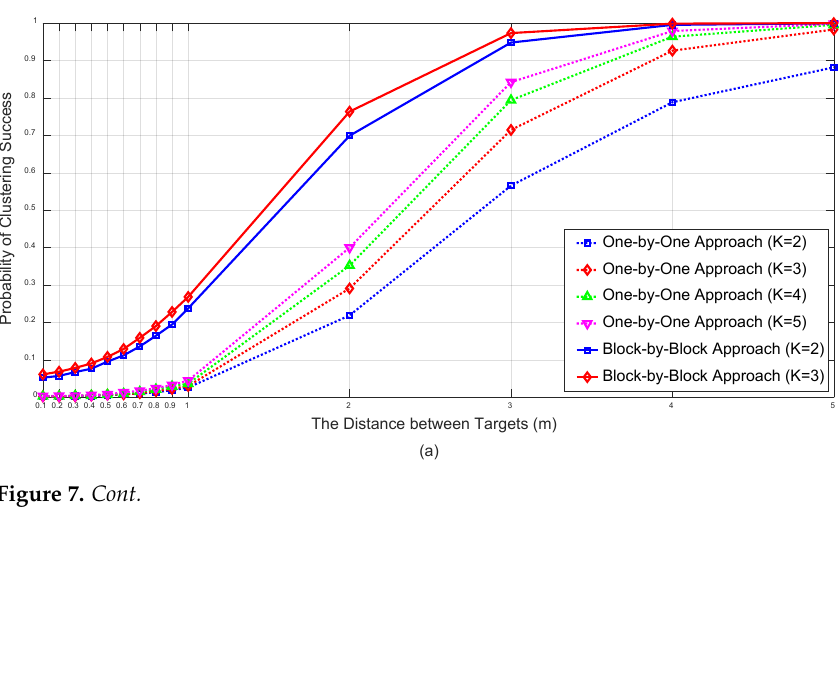
Figure 6. PCS ( a ) and NRMSE ( b ) vs. within-target distance with N = 6 under σ w = σ v = 0.3 (deg). σ u im im